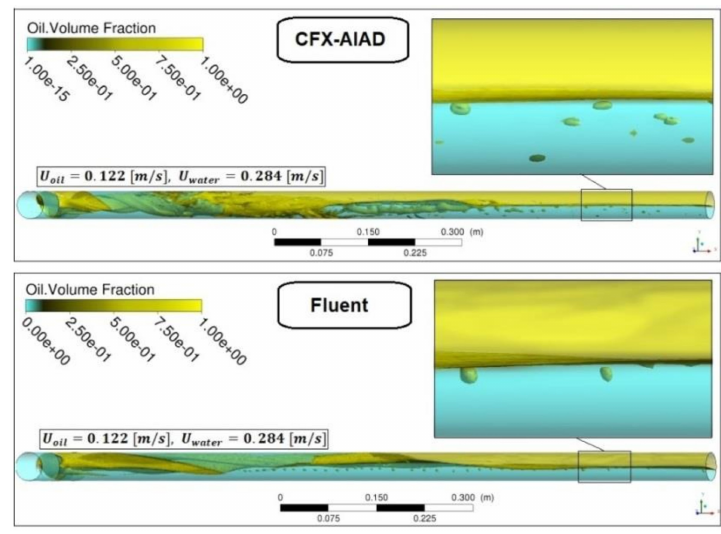
Figure 19. Oil volume fraction in the entire domain at U oil = 0.122 m / s, U water = 0.284 m /